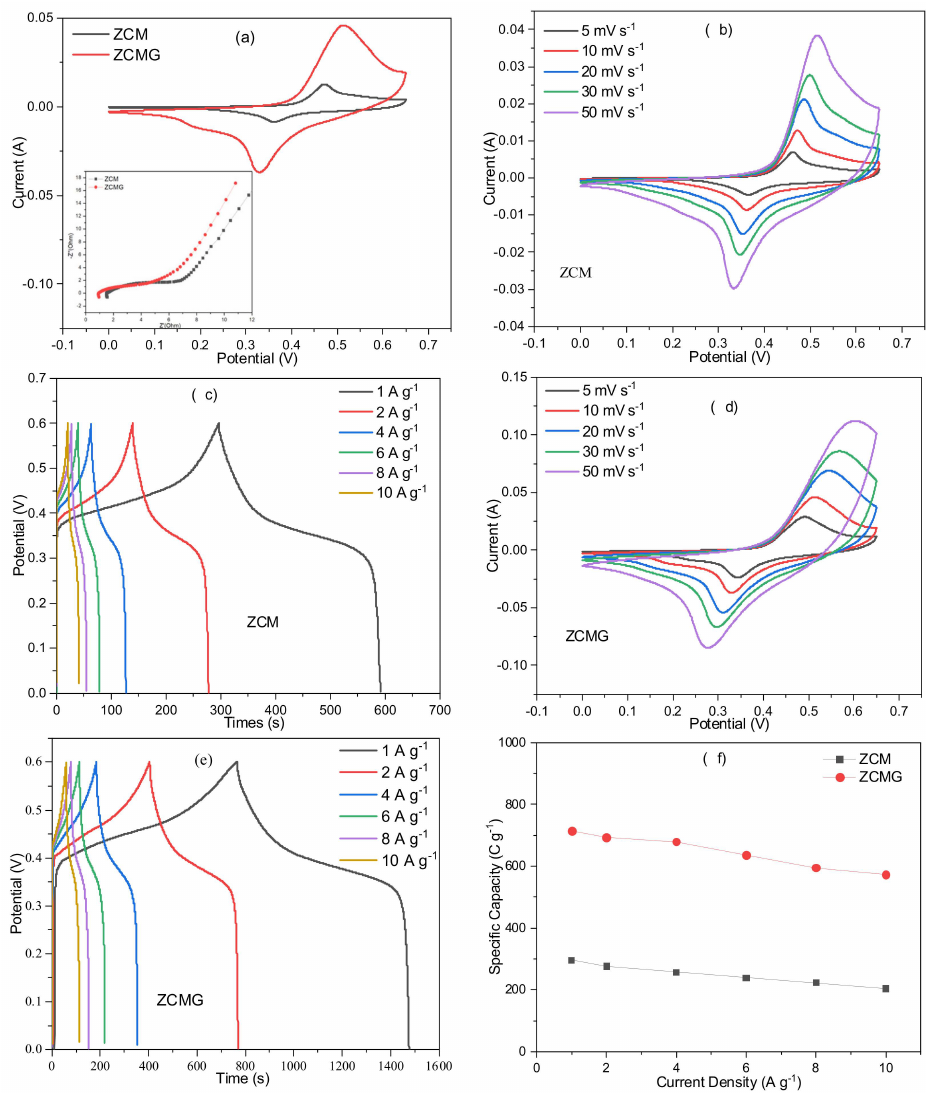
Figure 7. ( a ) CV plots of ZCM and ZCMG at 10 mV s − 1 (Inset shows the Nyquist plots of ZCM and ZCMG from 0.01 Hz to 100 kHz). ( b ) CV plots of ZCM at different scan rates. ( c ) GCD plots of ZCM at different current densities. ( d ) CV plots of ZCMG at different scan rates. ( e ) GCD plots of ZCMG at different current densities. ( f ) Specific capacity plots of ZCM and ZCMG at different current